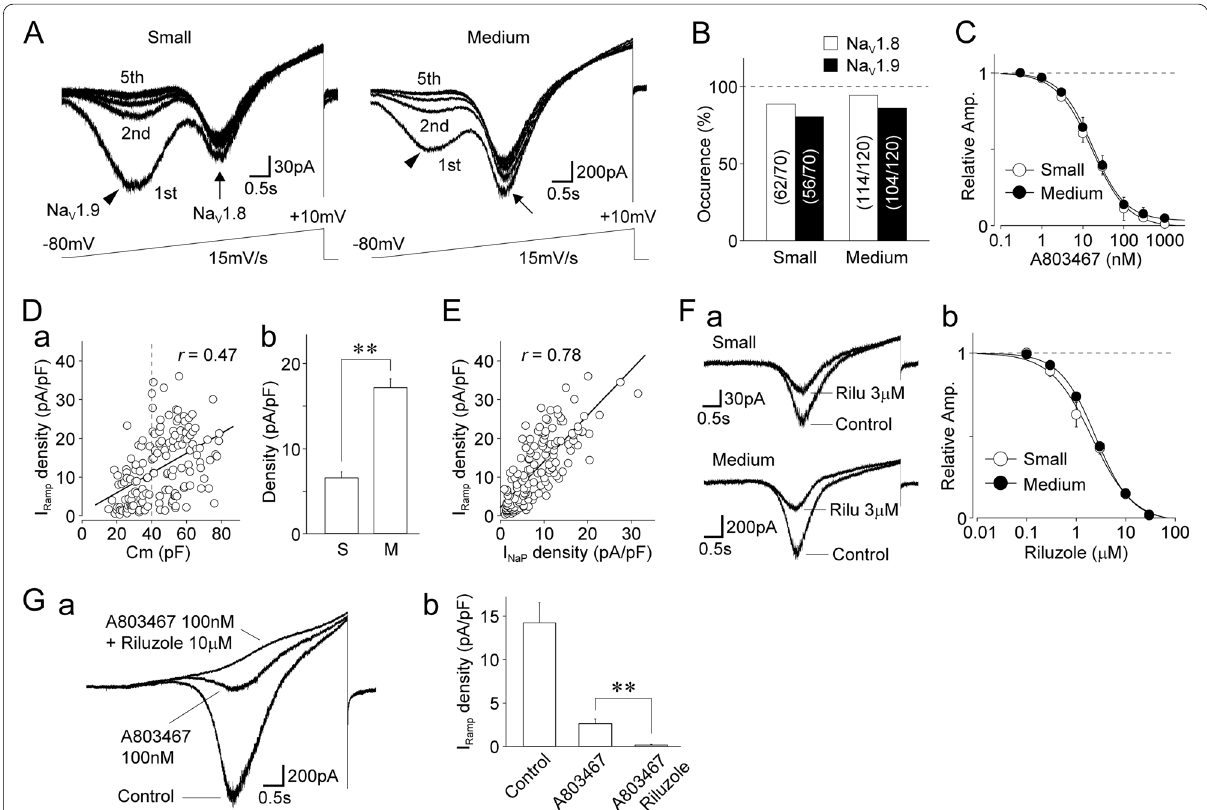
Fig. 2 Slow voltage‑ramp‑induced currents mediated by TTX‑R Na + channels in dural afferent neurons. A. Typical traces of slow voltage‑ramp‑induced TTX‑R I Na recorded in small‑ ( a ) and medium‑sized ( b ) DiI‑positive neurons. TTX‑R I Na were elicited by five successive voltage‑ramp stimuli every 15 s (6 s duration; up to 10 mV depolarization at a V H of ‑80 mV; 15 mV/s). Notably, voltage‑ramp stimuli elicited + “W‑shaped” membrane currents, which are potentially mediated by Na V 1.9 (left, arrowheads) and Na V 1.8 (right, arrows). Moreover, the Na V 1.9‑mediated ramp currents rapidly and completely disappeared within 3 min. B. Occurrence of Na V 1.8‑ and Na V 1.9‑mediated ramp currents in small‑ and medium‑sized DiI‑positive neurons. The values in parenthesis represent the number of DiI‑positive neurons showing Na V 1.8‑ and Na V 1.9‑mediated TTX‑R I Ramp . The occurrence of Na V 1.8‑ and Na V 1.9‑mediated ramp currents was determined immediately after the whole‑cell configuration was made. C. Concentration–response relationships of A803467 for TTX‑R I Ramp . The points and error bars represent the mean and SEM from eight small‑ and seven medium‑sized DiI‑positive neurons. D. a , Scatter plot of the density of TTX‑R I Ramp against membrane capacitance (Cm) obtained from the same neurons ( n 152). The linear trend line represents the best fit using a least‑squares fit ( r 0.47). b , The mean values = = of the density of TTX‑R I Ramp in small‑ (S) and medium‑sized (M) DiI‑positive neurons. The columns and error bars represent the mean and SEM from 60 small‑ and 92 medium‑sized DiI‑positive neurons. **; p < 0.01 (unpaired t‑test). E. Scatter plot of the density of TTX‑R I Ramp against TTX‑R I NaP obtained from the same neurons ( n 152). The linear trend line represents the best fit using a least‑squares fit ( r 0.78). F. a , Typical traces of slow = = voltage‑ramp‑induced TTX‑R I Na recorded in the absence and presence of 3 μM riluzole in small‑ (upper) and medium‑sized (lower) DiI‑positive neurons. b , Concentration–response relationships of riluzole for the TTX‑R I Ramp . The points and error bars represent the mean and SEM from six small‑ and eight medium‑sized DiI‑positive neurons. G. a , Typical traces of slow voltage‑ramp‑induced TTX‑R I Na recorded in the absence and presence of 100 nM A803467 and 100 nM A803467 plus 10 μM riluzole in medium‑sized DiI‑positive neurons. b , Changes in the current density of slow voltage‑ramp‑induced TTX‑R I Na by 100 nM A803467 and 100 nM A803467 plus 10 μM riluzole. The columns and error bars represent the mean and SEM from eight medium‑sized DiI‑positive neurons. **; p < 0.01 (paired